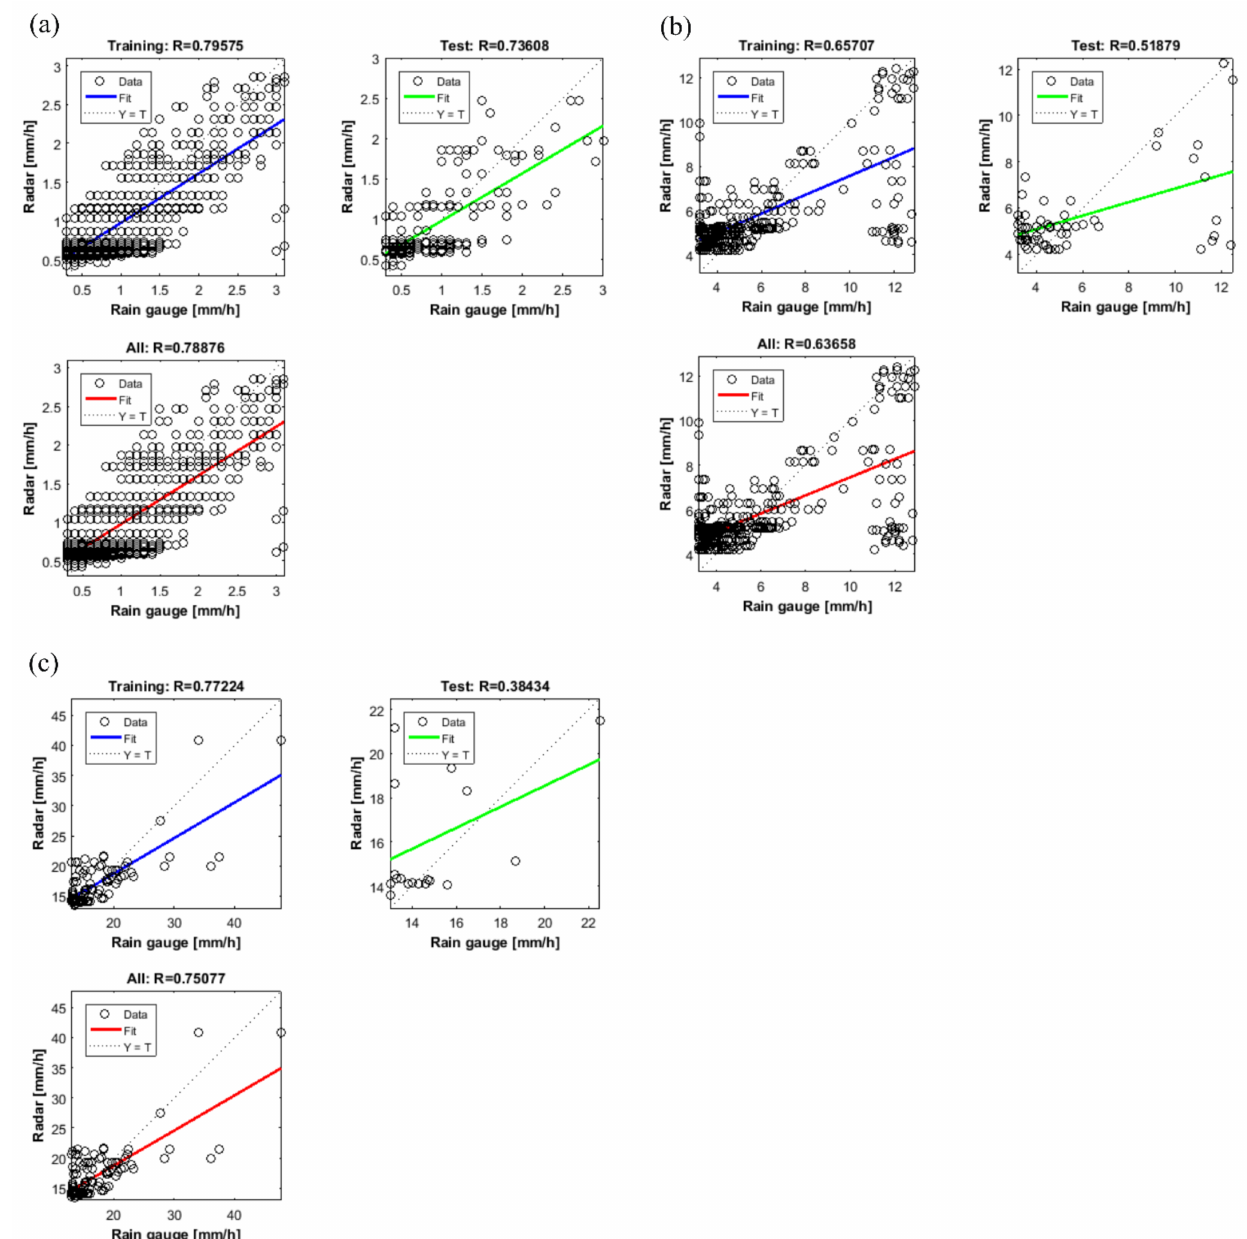
Figure 11. Scatter plots of radar rainfall estimates based on ANN versus rainfall measurements from the gauges at ( a ) low, ( b ) medium, and ( c ) high intensity rainfall. The straight line is the regression